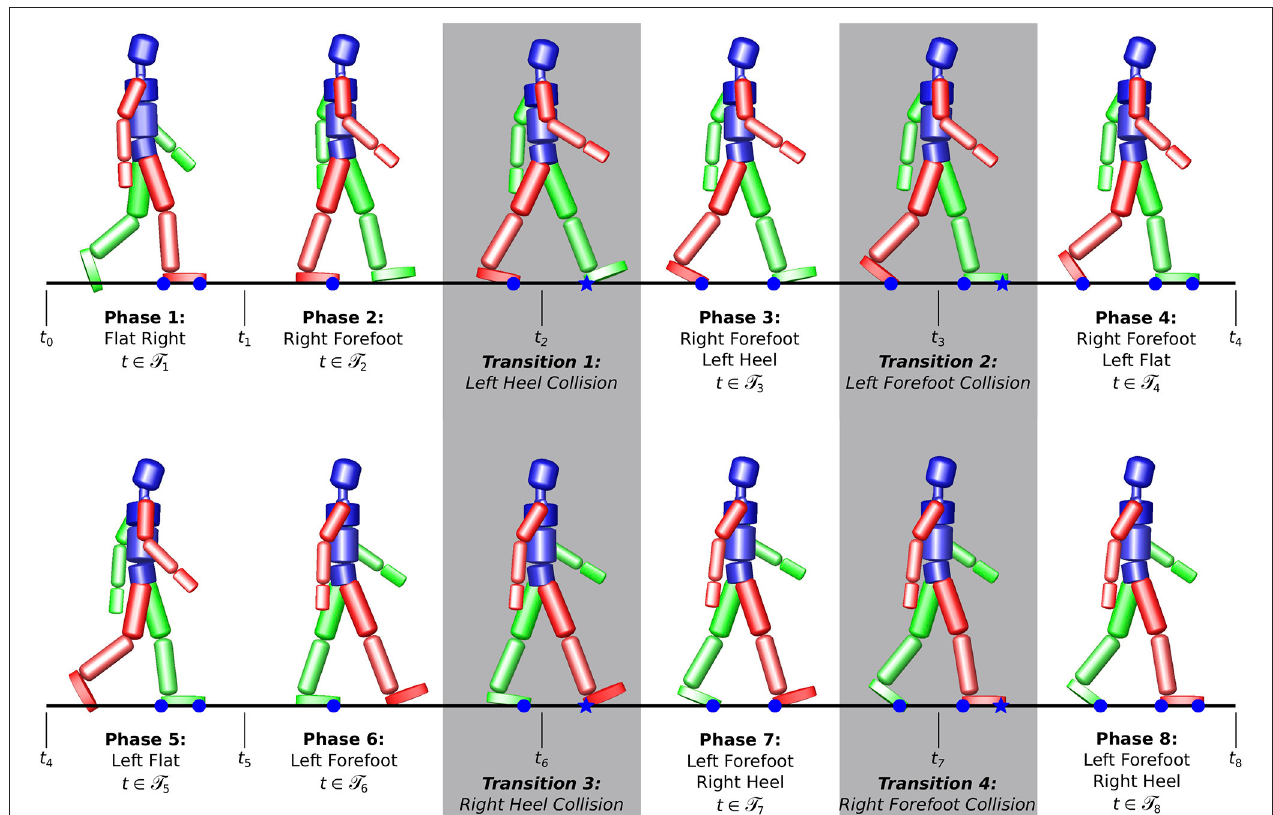
FIGURE 4 | Gait phases for the optimal control problem. Transition phases (gray) are introduced to account for the discontinuities occurring to the velocities ˙ q at ground collision when a new contact is